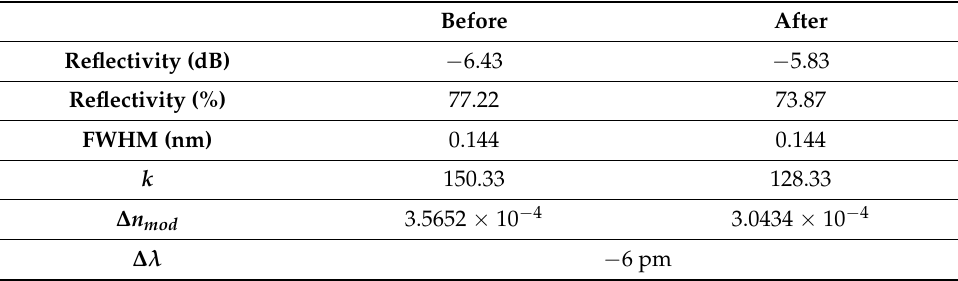
Table 1. Spectral characteristics of the PbP -FBG before and after exposure to γ -radiation. Before